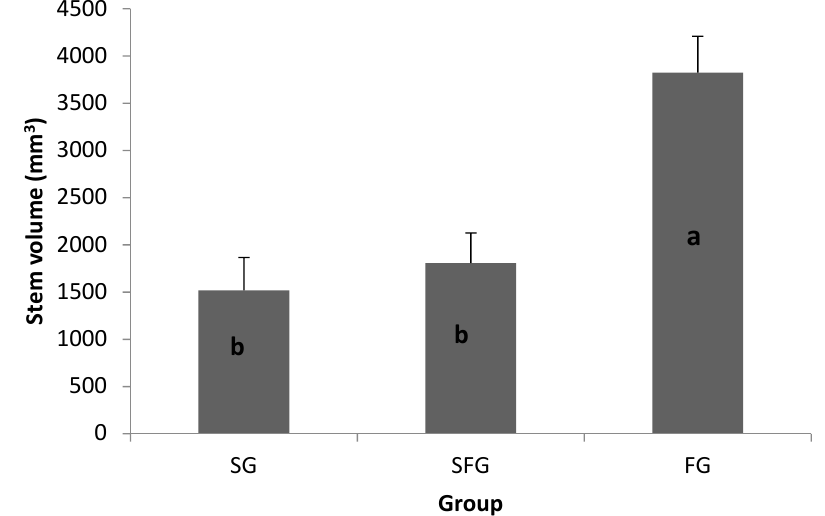
Figure 2. Mean stem volume (mm 3 ) (+SE) of three groups at Day 34 under near-optimal greenhouse